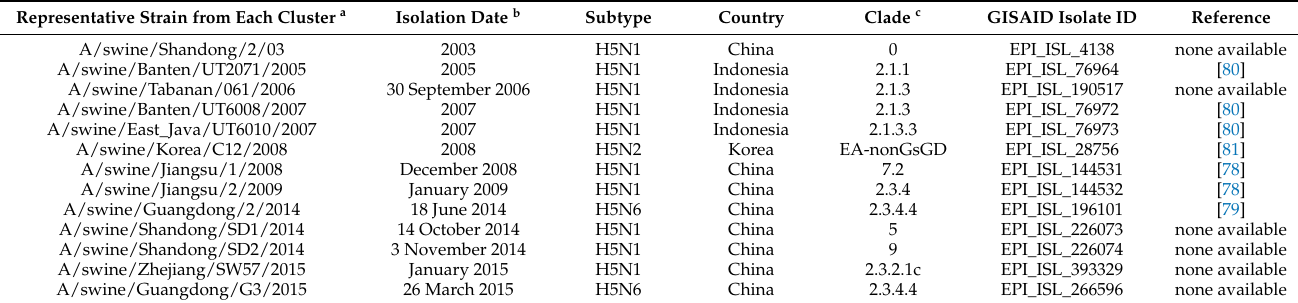
Table 2. H5 IAVs-S isolated in Asian